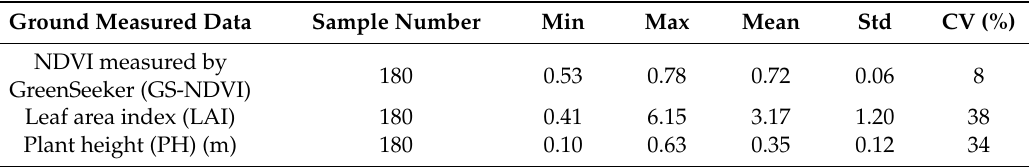
Table 2. Descriptive statistics for ground measured